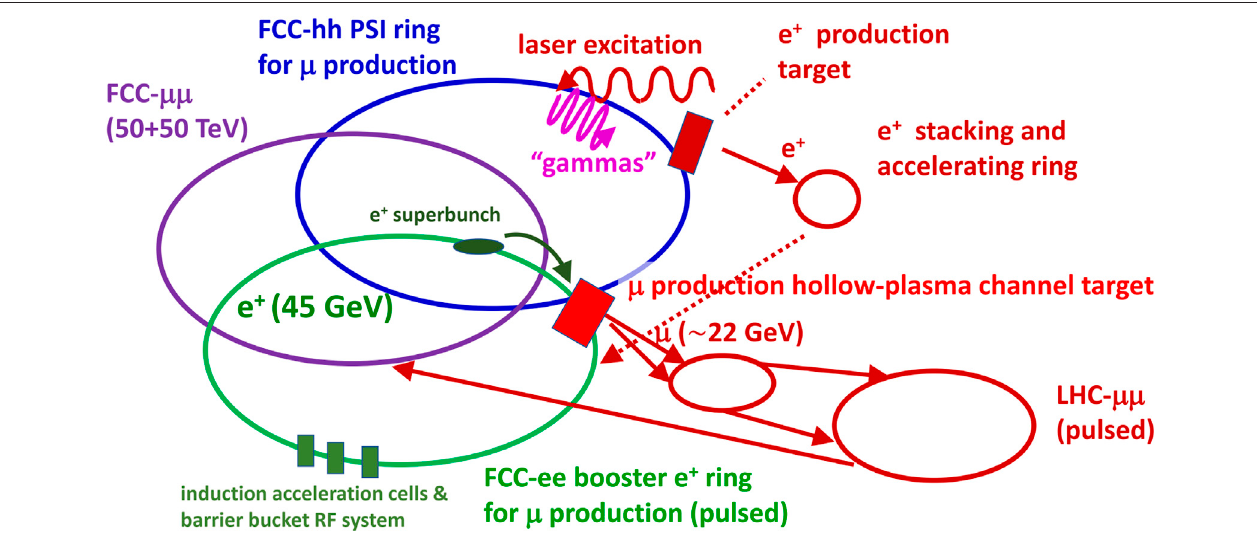
FIGURE5| Conceptofa100 TeV μ colliderbasedonFCC-hhandFCC-ee.InoneoftheFCC-hhrings,partiallystrippedheavyionsarecollidedwithapulsedlaser togenerateintensehigh-energygammaraysthatareconvertedintopositrons,whichareaccumulated,thenaccelerated,andinjectedintoabarrierbucketintheFCC-ee boosterring.Theresultingsuperbunchisbroughttoapositronenergyof45 GeV,withinduction acceleration,wherethesuperbunchisextracted andsentintoaplasma target, leading to a plasma electron density enhancement and, thereby, ampli fi ed annihilation into muon pairs. The muons are accelerated in a modifed SPS and LHC, to be fi nally injected and accelerated in the second FCC-hh collider ring. This is a modi fi ed version of the scheme presented in Ref.